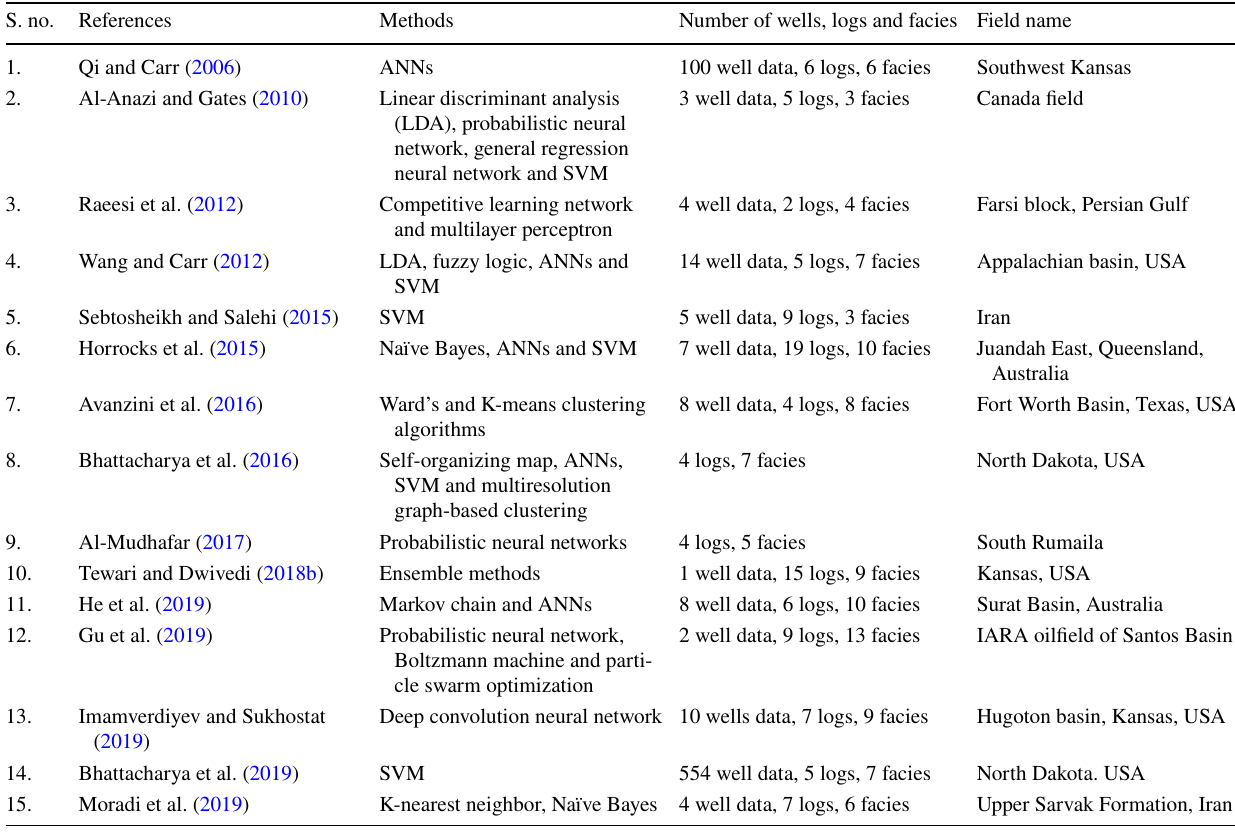
Table 1 Summary of some important published research works related to mudstone lithofacies classification utilizing machine learning tech-